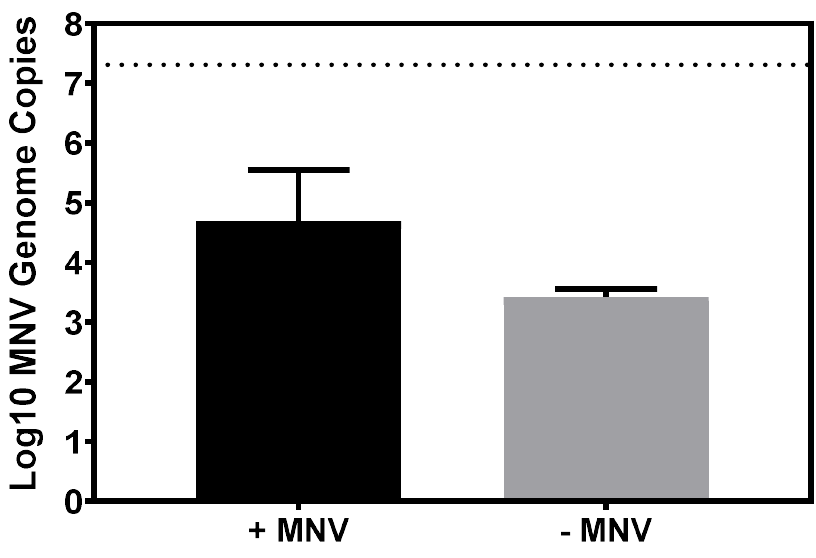
Figure 5. MNV attachment to C. albicans . RT-PCR showed that MNV genomes were detected in C. albicans pellets after 1 h of incubation ( n = 3), while C. albicans pellets without MNV remained at the limit of detection (log 10 3.3 MNV genome copies). Dashed line represents amount of input virus. Statistical analysis was performed using a paired Student’s t test in GraphPad Prism.